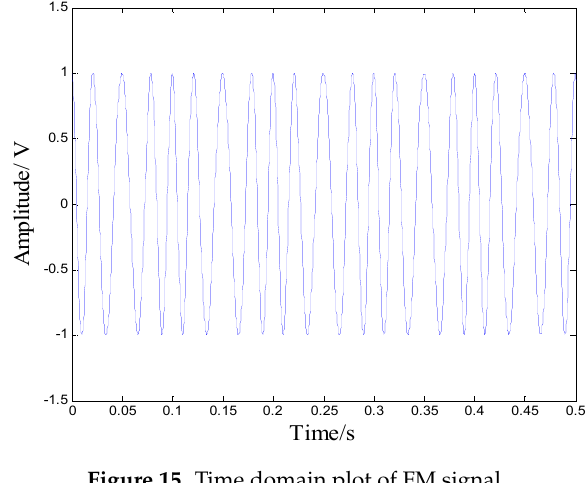
Figure 15. Time domain plot of FM signal.